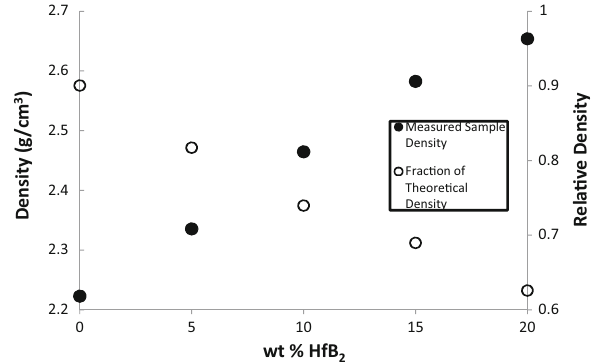
Fig. 5 Boron carbide/hafnium diboride composite samples; densities and fraction of theoretical densities, i.e., relative densities